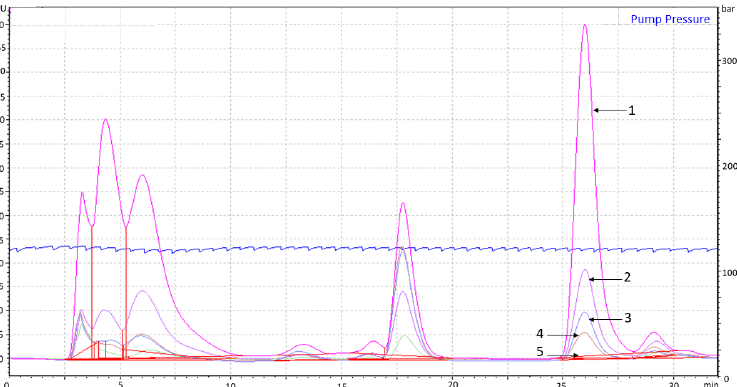
Figure 5. HPLC grams of differently dried sundew tissue extract. The drying treatments of the overlaid HPLC grams are marked as follows: 1) frozen ( − 20 °C), 2) freeze-drying (43 h), 3) room temperature (43 h), 4) herbal-dryer (+45 °C, 27 h), and 5) oven (+105 °C, 24 h).